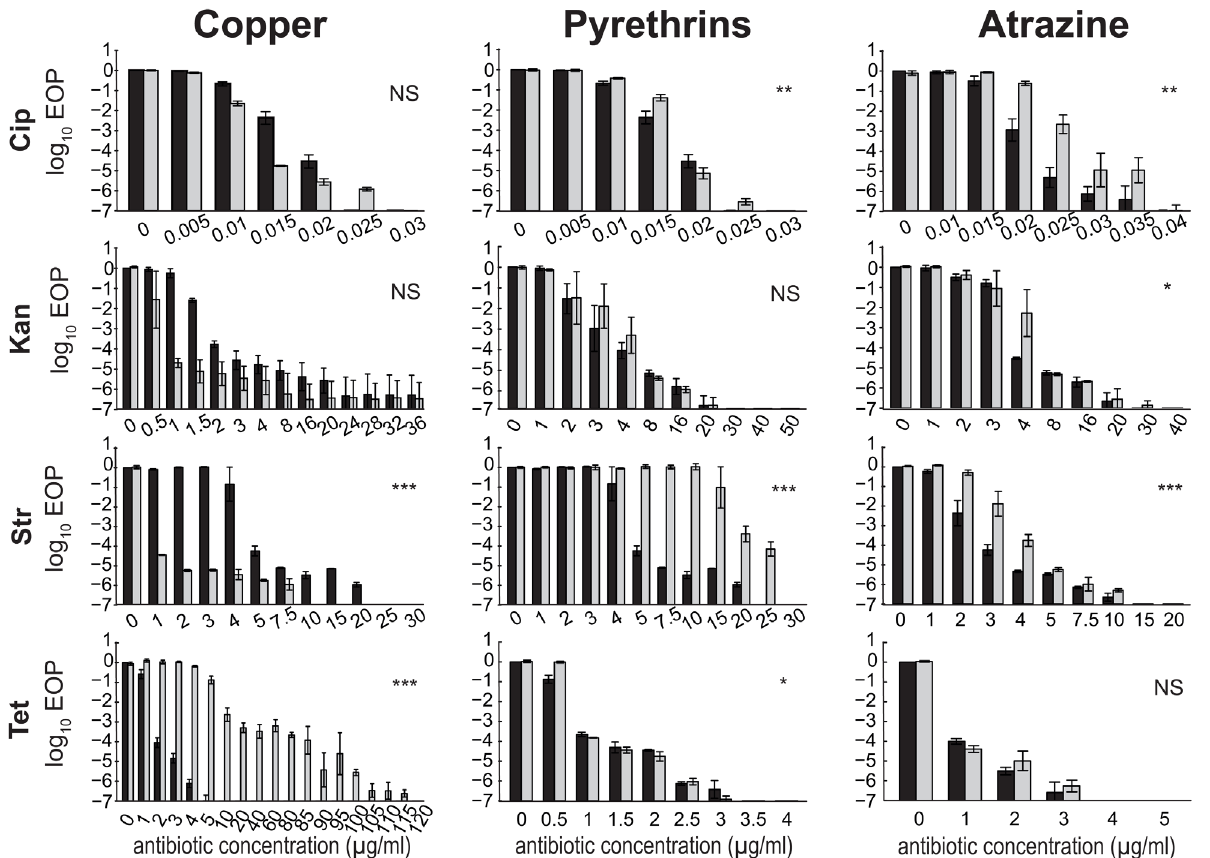
Figure 1. Change in EoP when E. coli BW25113 is (grey) or is not (black) exposed to biocides. The x-axes scale is antibiotic concentrations in µg/mL. Biocide concentrations used were 450 µg/mL for copper ammonium acetate, 140 µg/mL for pyrethrin, and 1000 µg/mL for atrazine. Values are means of at least three independent experiments; error bars are standard errors (SEM, with SEM=standard deviation/ √ n). Asterisks indicate P-values for antibiotic*herbicide interaction terms (see Materials and Methods). * P <0.05; ** P <0.01; *** P <0.001; ns, not significant.